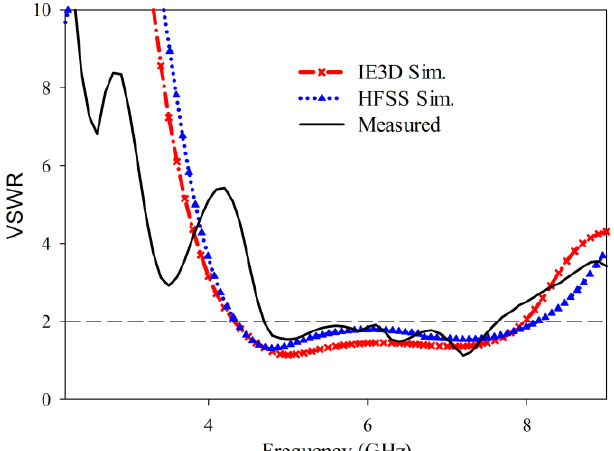
Figure 5: Measured and simulated VSWR graphs of the LPMA.